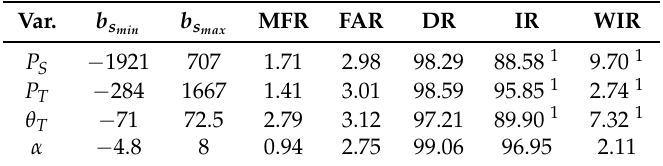
Table 6. Monte-Carlo Simulation: sensor